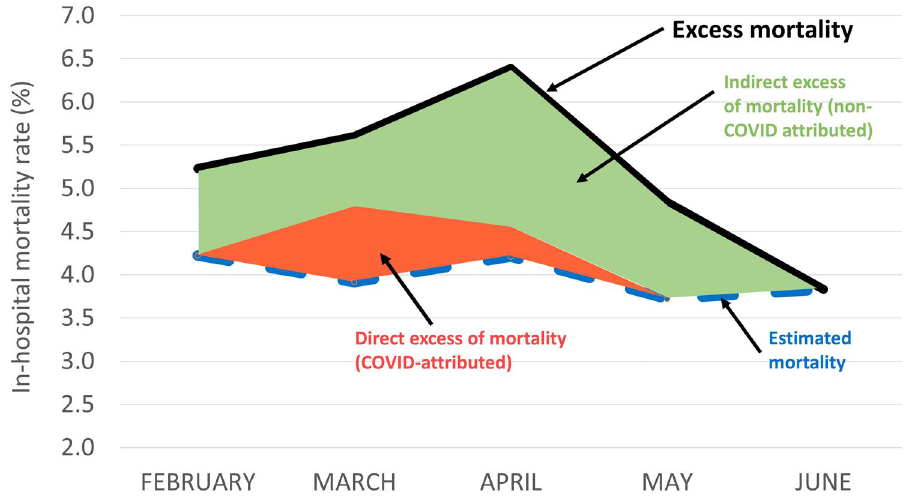
Figure 1. Estimated and observed trends of in-hospital mortality at the Virgen del Rocío University Hospital during the first pandemic wave (sub-period 1). Estimated mortality is the in-hospital mortality for this period observed in 2017–2019. Excess mortality due to COVID-19 results in the addition of both direct (COVID- attributed mortality) and indirect (non-COVID attributed mortality). Mortality rate is expressed as deaths for 100 admissions.